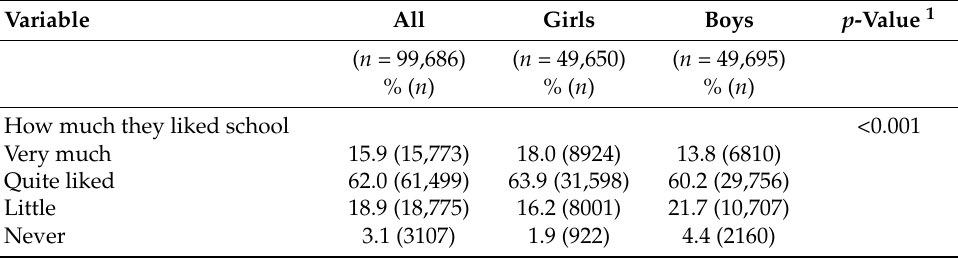
Table 2. School engagement reported by girls and boys aged 9–11 years [49].